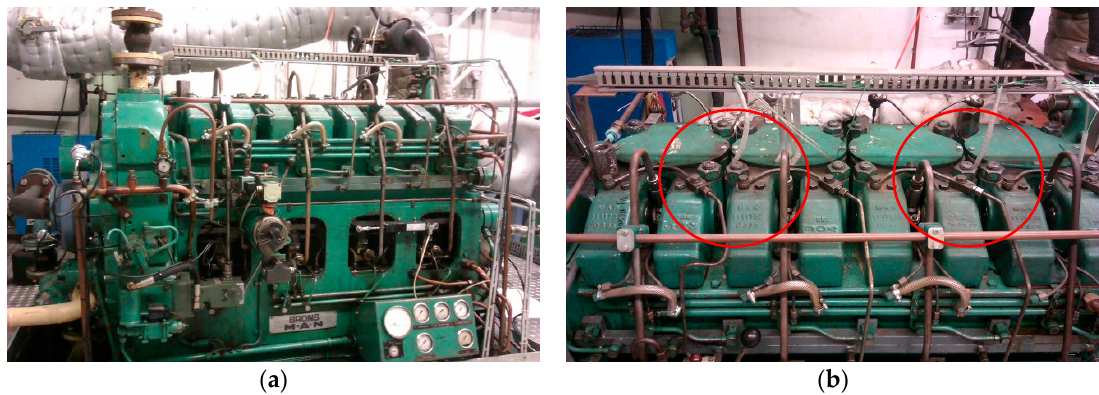
Figure 1. Engine test bed: ( a ) Overview of the test bed; ( b ) the in-cylinder pressure sensor installation in the test bed (the red circle).